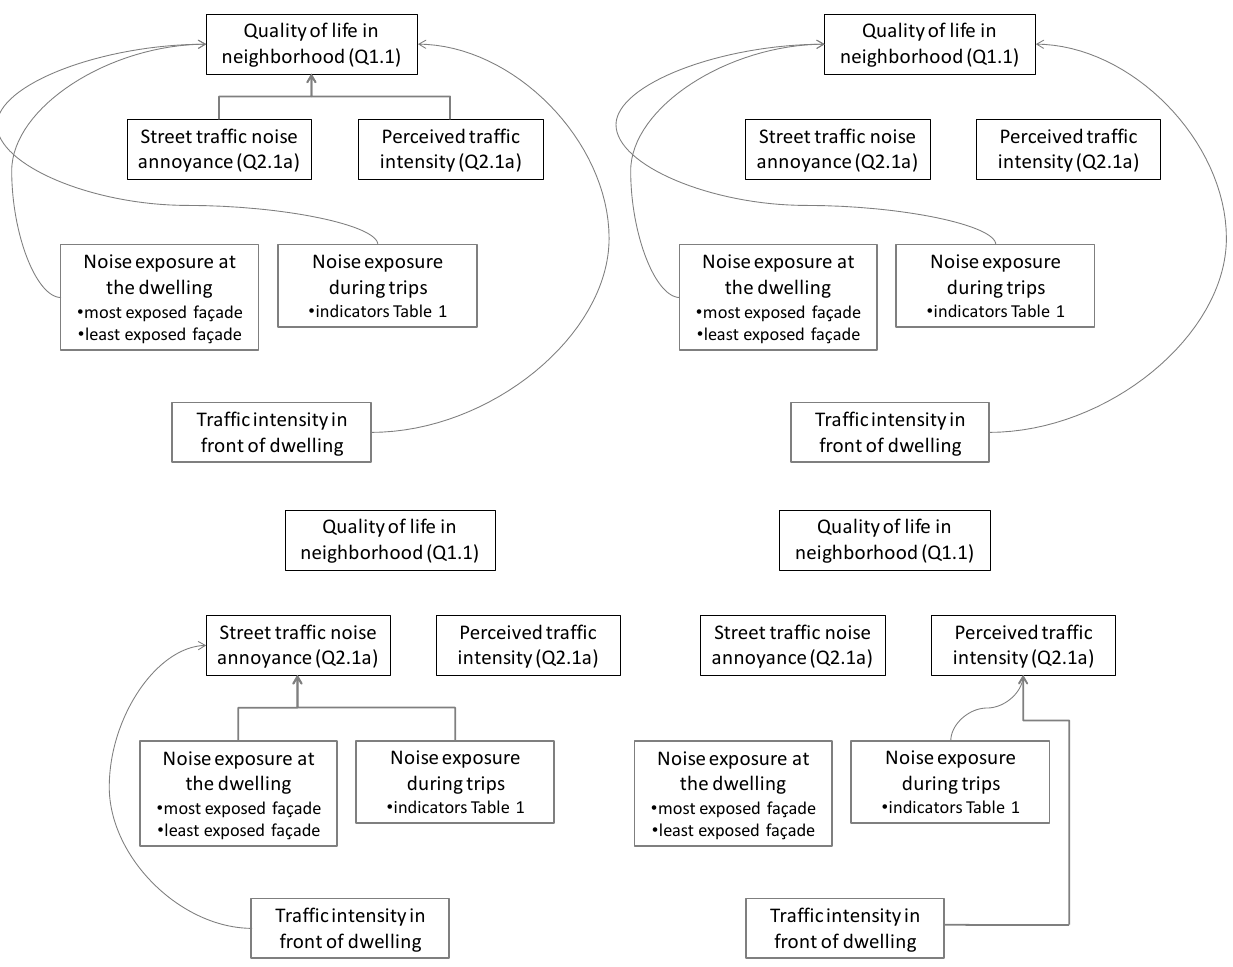
Figure 9. Models studied using logistic regression: a model for QoL including questionnaire response and data from GIS (upper left); a model for QoL including only GIS data (upper right); sub models for street traffic noise annoyance and perceived traffic intensity (lower left and